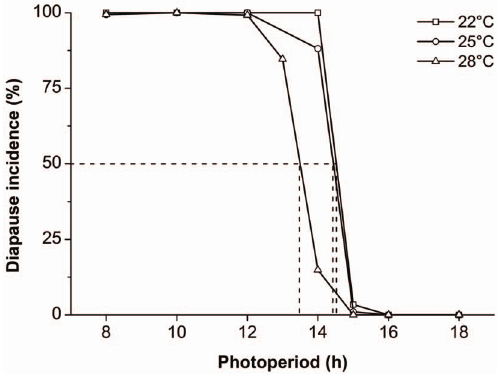
Figure 1. Photoperiodic response curves for the induction of pupal diapause in H.cunea at 22, 25 and 28 u C (3 replicates, each of at least 30 individuals/treatment; total n=147–1341).